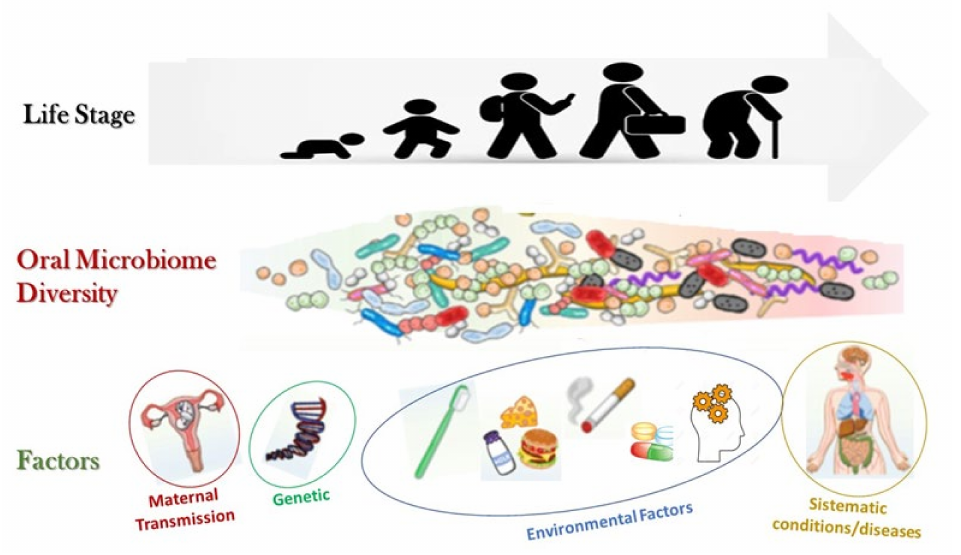
Figure 2. Evolution of oral